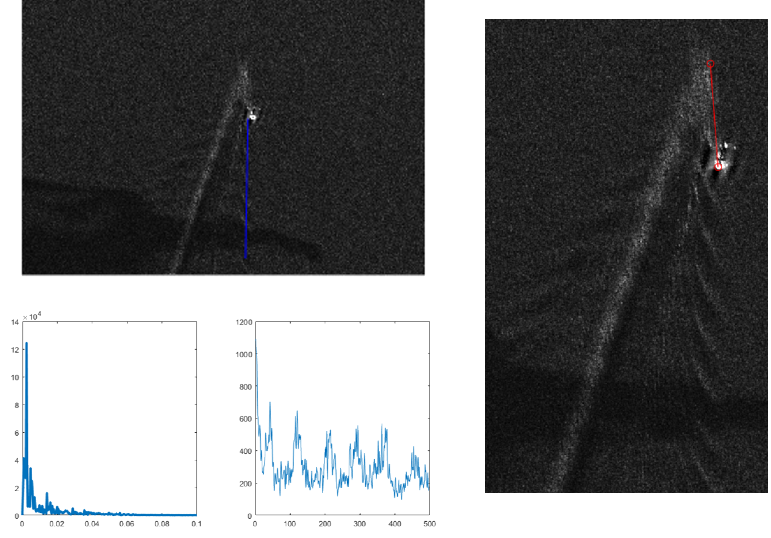
Figure 5. External wake component detection and processing for kinematics estimation purposes. In the upper left, an SAR image example, representing a moving vessel and its related wake, with a Kelvin cusp wave highlighted in color. On the right side, the identified Azimuth shift displacement is highlighted in color. On the lower left side, the results of the frequency analysis on the Kelvin cusp wave signal are shown (spectrum on the left side, the sampled signal on the right side). (COSMO-SkyMed Product— c (cid:13) ASI 2016 processed under license from ASI—Agenzia Spaziale Italiana, all rights reserved, distributed by